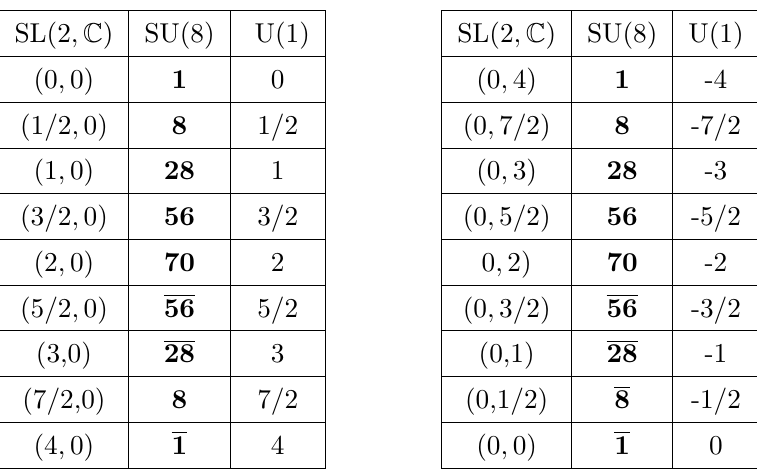
Table 6 . The irreducible chiral doubleton supermultiplets of SU(2 ; 2 j 8) and its conjugate, with the highest spin 4. Scalars here are singlets of SU(8). The vector (cid:12)eld strengths and their duals transform in 28 and (cid:22)28 of SU(8).